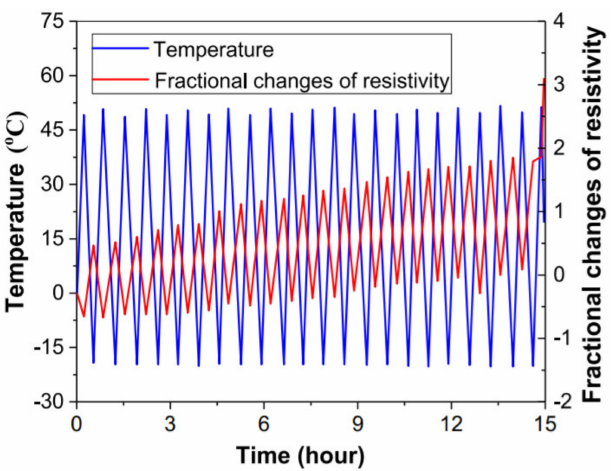
Figure 15. The fractional change in resistivity during temperature variation. Reproduced with permission from [70], Elsevier,